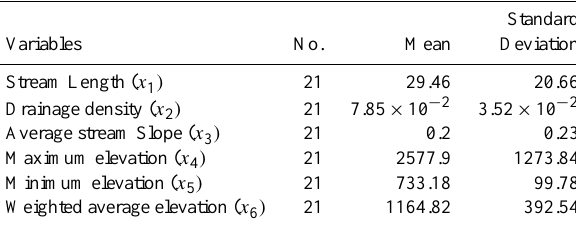
Table 1. Statistics of physiographic variables.